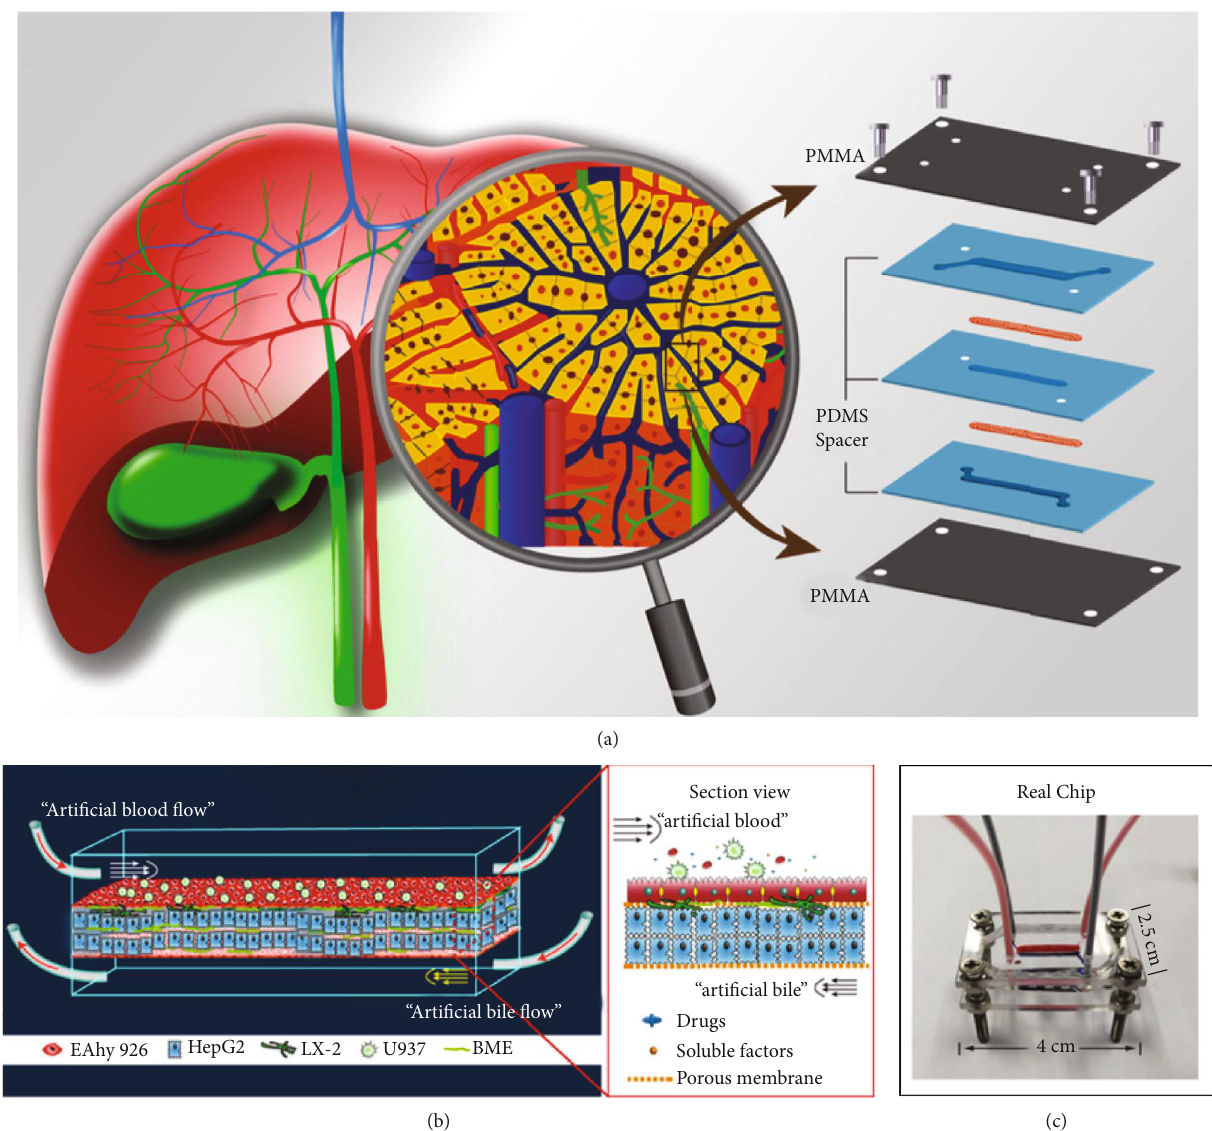
Figure 1: (a) Schematic of a liver sinusoid structure and the LSOC microdevice. Left: an illustration of the physiological structure of the liver sinusoid in the liver. Right: the design of the LSOC microdevice. (b) Schematic diagram of four cell lines seeded in the device. (c) Picture and size measurement of the chip. Reproduced (or adapted) with permission [38], ©2019, American Institute of